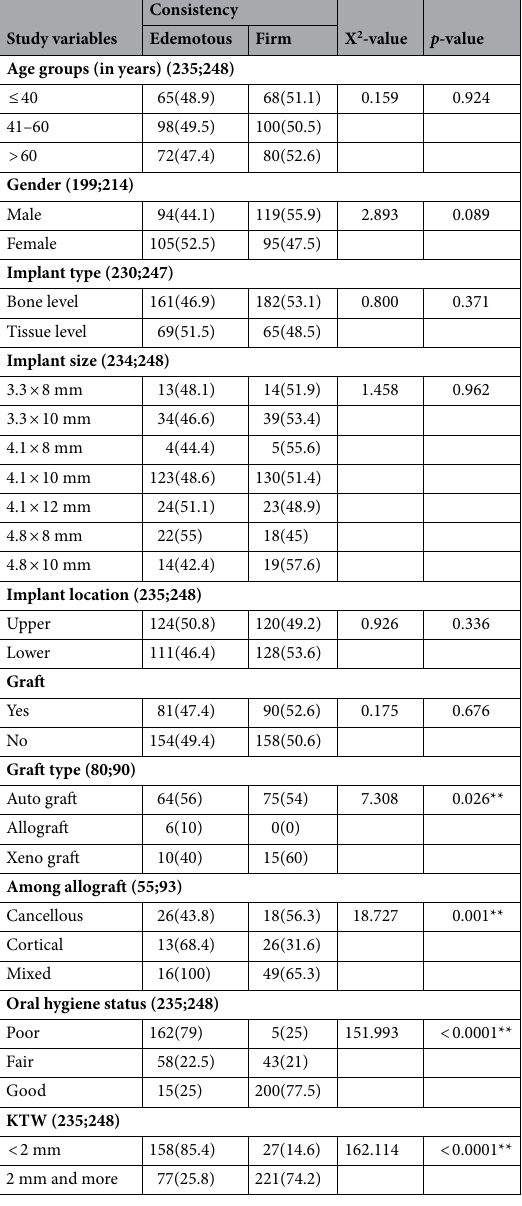
Table 5. Association between consistency and other study variables. *Keratinized tissue width. **Statistically